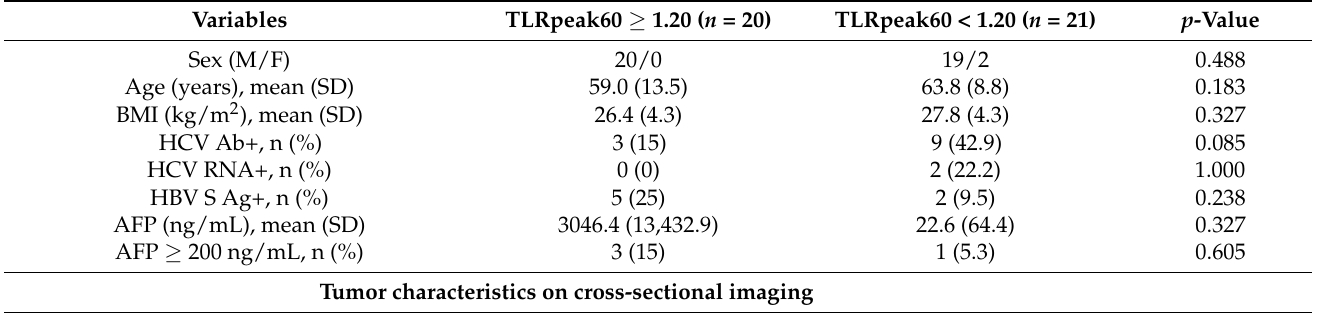
Table 4. Comparison between the two groups of patients according to metabolic activity based on TLRpeak60 with the cut-off in the p50